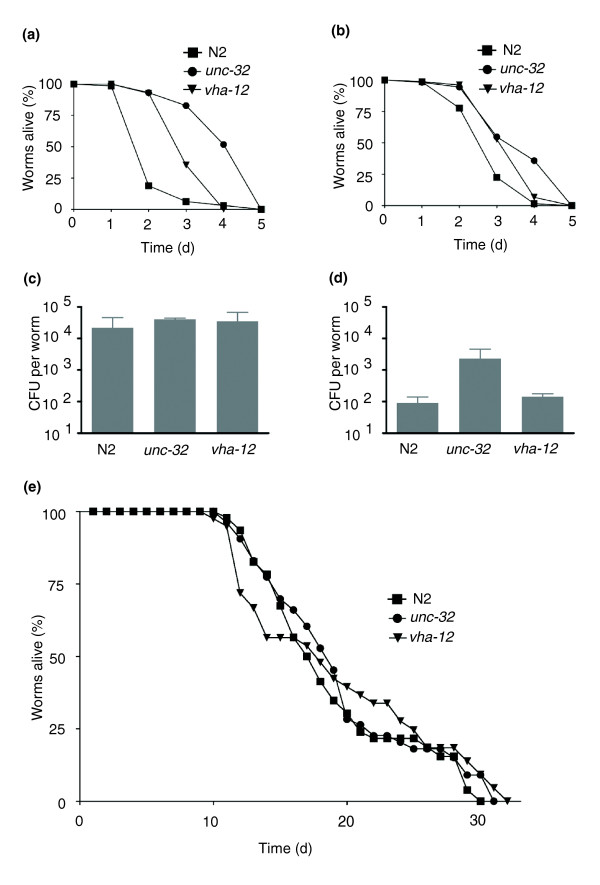
Suppression of necrosis increases resistance of worms to infection. Both vha-12(n2915) and unc-32(e189) are associated with a defect in vacuolar H+-ATPase activity and, consequently, reduced necrosis. Following infection with (a) E. carotovora and E. carotovora (b) E. carotovora, the differences between wild-type N2 and vha-12(n2915) or unc-32(e189) survival are highly significant (log-rank test, p value < 0.0001). Data shown are representative of three independent experiments. (c,d) Bacterial load in the intestines of wild-type and mutant C. elegans (indicated on the horizontal axes), after 24 h exposure to E. carotovora (c) and P. luminescens (d). The number of colony-forming units (CFU) per worm was measured and bars represent the standard errors from two independent experiments. (e) Life-span assays for the mutants vha-12(n2915) and unc-32(e189) and wild-type N2 on non-pathogenic OP50 E. coli. Differences between the three strains are not significant (log-rank test, p value > 0.05).